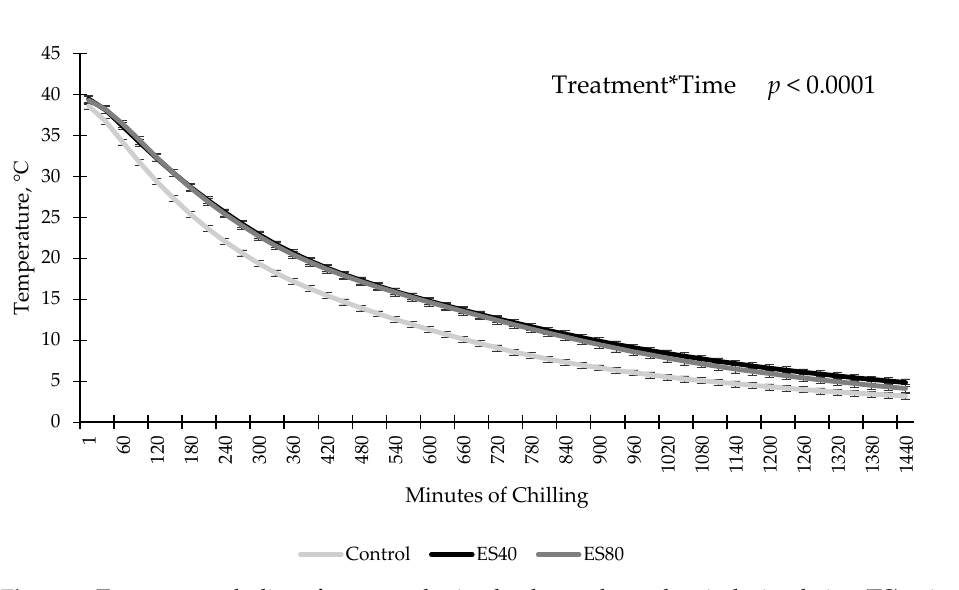
Figure 1. Temperature decline of carcass submitted to low-voltage electrical stimulation (ES) prior to chilling. Data are depicted as least square means ± SEM. Treatments are as follows: Control = no ES, ES40 = 40 V of ES, ES80 = 80 V of ES. Electrical stimulation was applied for 60 s in 4 s on, 2 s off intervals.